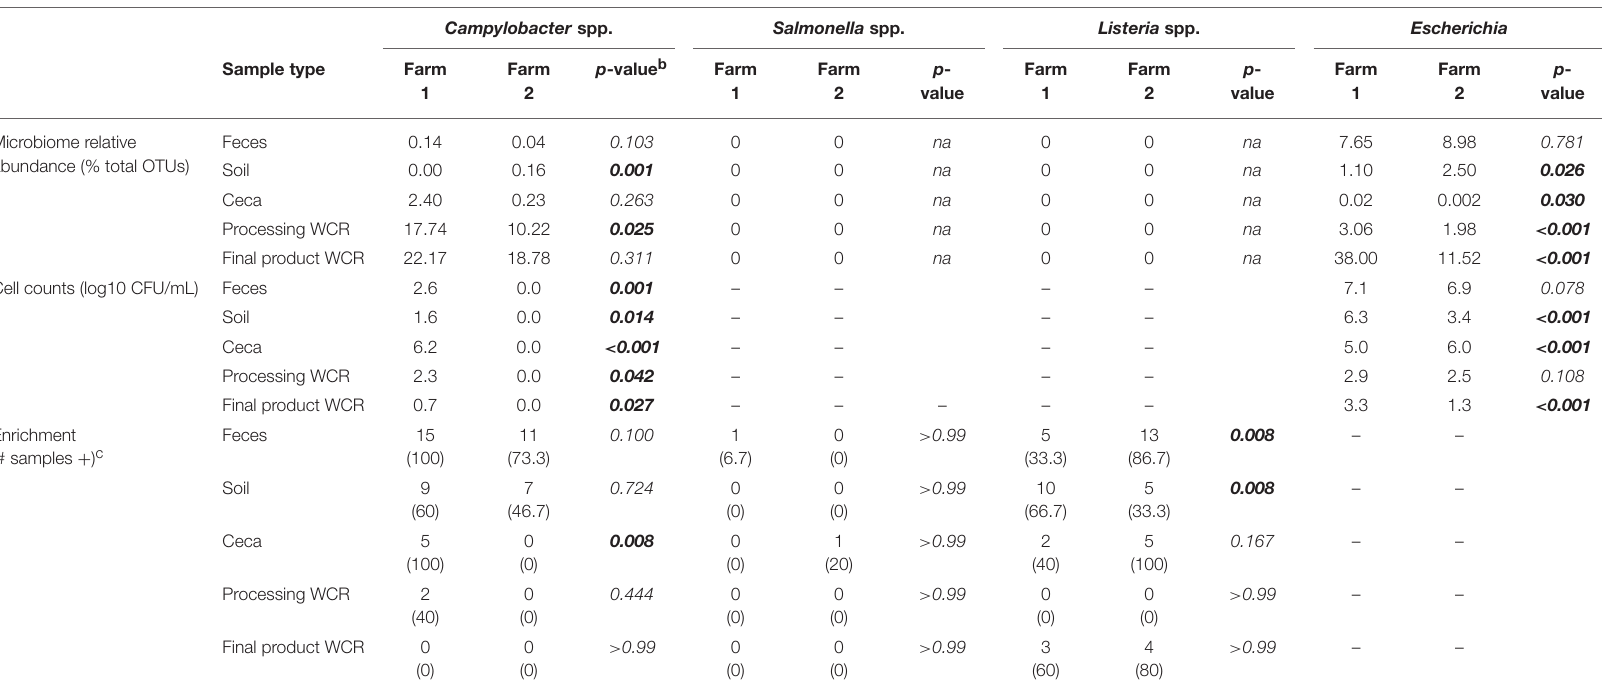
TABLE 6 | Putative foodborne pathogen ( Campylobacter, Salmonella, Listeria ) and indicator ( Escherichia ) levels in different sample types throughout the farm-to-fork continuum from two pastured broiler flocks, measured by microbiome, direct cell counts, and enrichments a